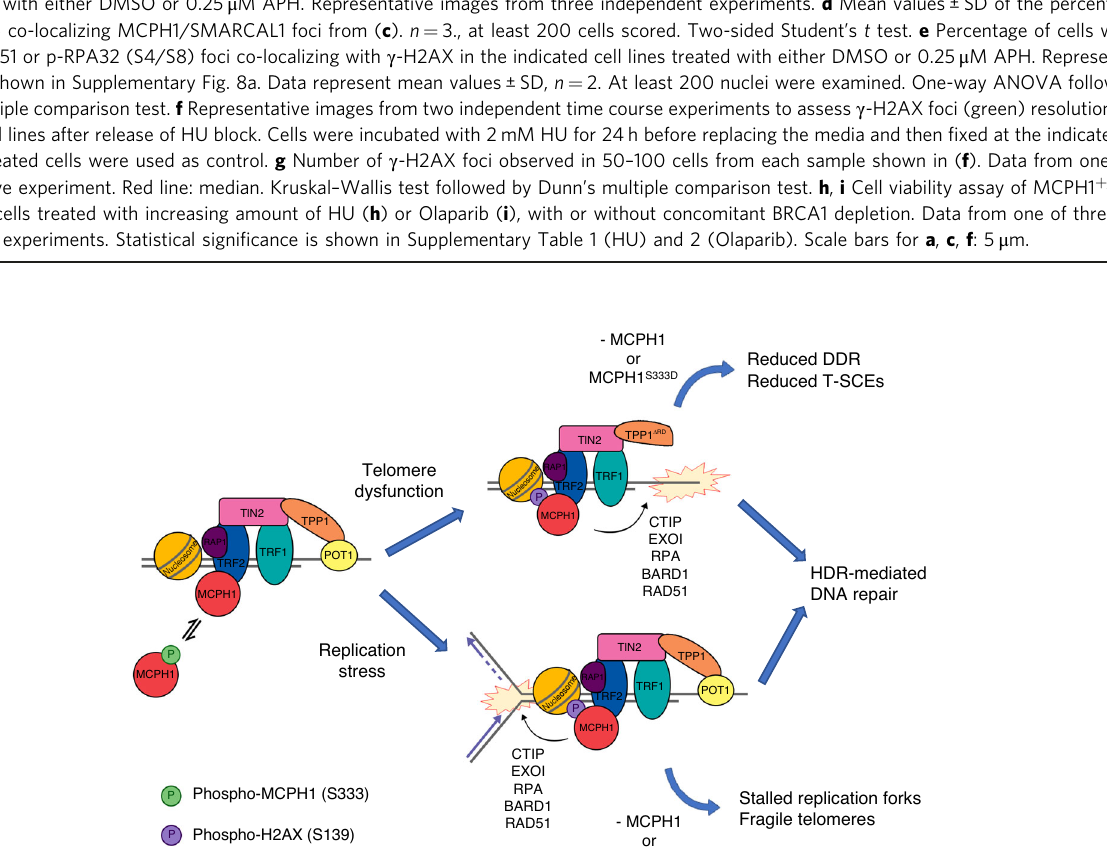
Fig. 7 Schematic depicting MCPH1 ’ s role at telomeres. MCPH1 interacts with TRF2 when S333 is de-phosphorylated, while this interaction is disrupted upon S333 phosphorylation. In unperturbed conditions, MCPH1 exists in equilibrium between the phosphorylated and the de-phosphorylated forms and its telomeric localization increases in S phase. Removal of POT1 through the overexpression of TPP1 Δ RD increases MCPH1 localization to telomeres that is dependent upon the interaction with both TRF2 and γ -H2AX. MCPH1 binding to TRF2 promotes the recruitment of HDR and end resection factors to initiate HDR at telomeres lacking POT1-TPP1. Cells lacking MCPH1 or expressing MCPH1 S333D display reduced recruitment of HDR factors and reduced T- SCEs, suggestive of HDR defects. Similarly, induction of replication stress at telomeres increases MCPH1 telomeric localization, promoted by its interaction with TRF2. In the absence of MCPH1 or upon overexpression of the phosphomimetic mutant MCPH1 S333D , replication forks stalling at telomeres increases and telomere replication is impaired, resulting in telomere fragility. These observations suggest that telomeric localization of MCPH1 is required for proper telomere replication by promoting stalled replication fork and BRCA1 de fi ciency can mediate synthetic lethality in many cancers 67,68 . Our data shows that MCPH1 knockout caused even takes longer time, suggesting the contribution of a MCPH1- higher sensitivity to Olaparib than BRCA1 knockdown, suggest- independent replication pathway that requires BRCA1. Our tel- omere SMARD analysis shows that, similar to its role at stalled